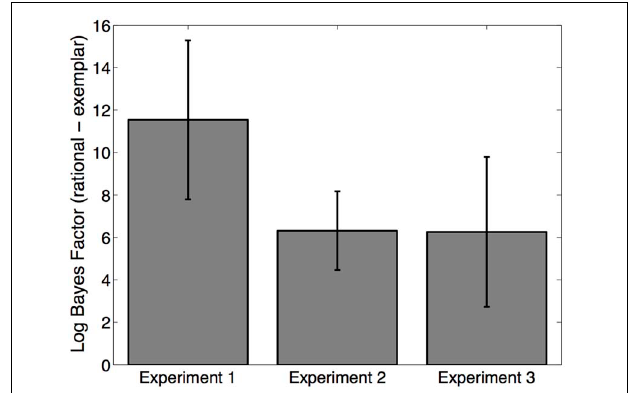
FIGURE 7 | Model fits. Log Bayes factor for the rational model relative to the exemplar model. Positive values favor the rational model. Error bars represent standard error of the